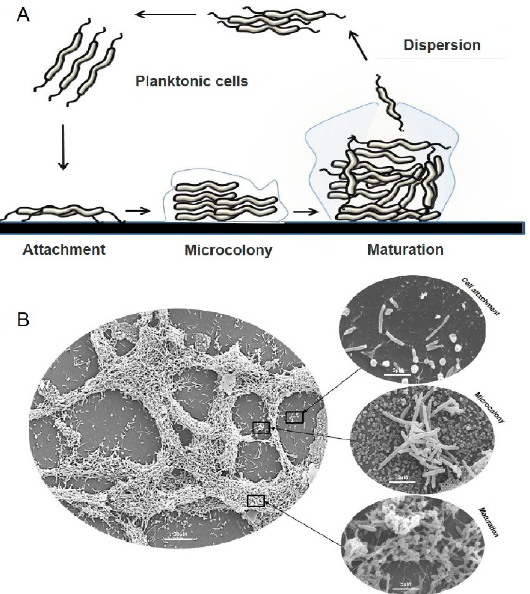
Figure 1. Cycle of biofilm development. ( A ) Planktonic cells swim and attach to surfaces (cell-to- surface and cell-to-cell) resulting in the formation of microcolonies. Mature biofilms can return to a planktonic lifestyle through dispersion and released seed cells complete the cycle of biofilm devel- opment. ( B ) Representative scanning electron microscopy ( SEM ) images of C . jejuni cultured under microaerobic conditions.